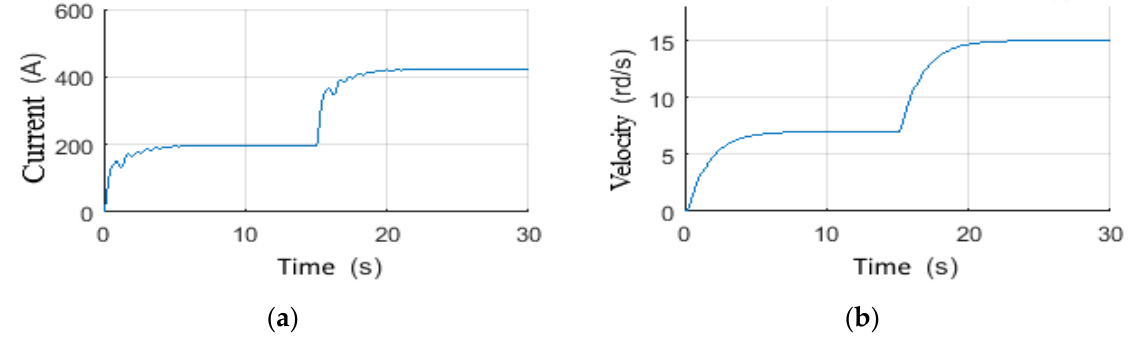
Figure 27. Observer-based controller responses for Top Drive: ( a ) Current, ( b ) Velocity.